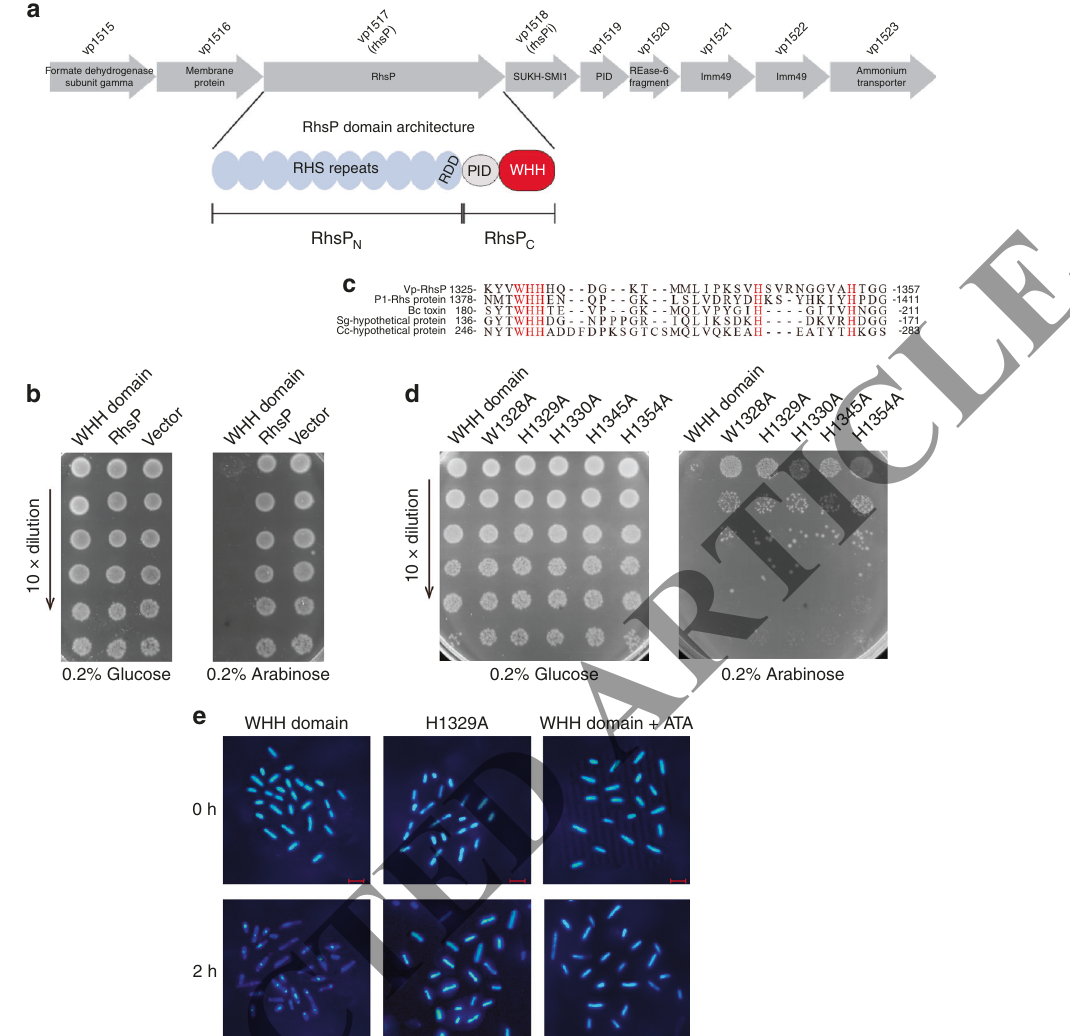
Fig. 1 RhsP is a putative bacterial toxin with DNase activity. a Genetic organization of the RhsP operon and the domain architecture of RhsP. The protein domains and fragments examined in this study are indicated. PID, PAAR-interacting domain; RDD, aspartic protease motif featured by conserved active site residues of R1092, D1105, and D1127. b Expression of WHH domain but not the full-length RhsP inhibits E. coli growth. FLAG-tagged RhsP (pBAD24- rhsP-F ) or WHH domain (pBAD24-WHH domain-F) was expressed in E. coli DH5 ⍺ and the cultured bacteria were 10-fold serially diluted and spotted on LB agar plate as indicated. The growth of bacterial E. coli on LB agar plate was shown. c The sequence alignment of RhsP with their homologs identi fi ed the key residues representing WHH motif (Vp: V. parahaemolyticus RIMD2210633; Pl: Photorhabdus luminescens (KZK71210.1); Bc: Bacillus cereus (WP_065224256.1); Sg: Sulfurimonas gotlandica (WP_008341295.1); Cc: Clostridium cellulolyticum (ACL75847.1)). d The effect of site-directed mutagenesis in the conserved amino acids identi fi ed in ( c ) on the toxicity of WHH domain. RhsP or various site-directed WHH domain mutant was expressed from pBAD24 in E. coli DH5 ⍺ . The cultured bacteria were 10-fold serially diluted and spotted on LB agar plate. The growth of E. coli on LB agar plate was shown. For ( b ) and ( d ), the expression of genes was repressed by glucose (left) and induced with arabinose (right). RhsP, WHH domain or its derivatives contain a FLAG epitope at their C-terminal. e Induction of WHH domain degrades bacterial chromosomal DNA. Fluorescence microscopy observation of E. coli DH5 ⍺ cells expressing the WHH domain (pBAD24-WHH domain-F) or its mutant H1329A (pBAD24-H1329A). Samples at 0 or 2 h after protein induction were stained with Hoechst 33342 to visualize DNA in the cells. Aurintricarboxylic acid (ATA) (1 mM) was used to inhibit DNase activity. Scale bar, 2 µ